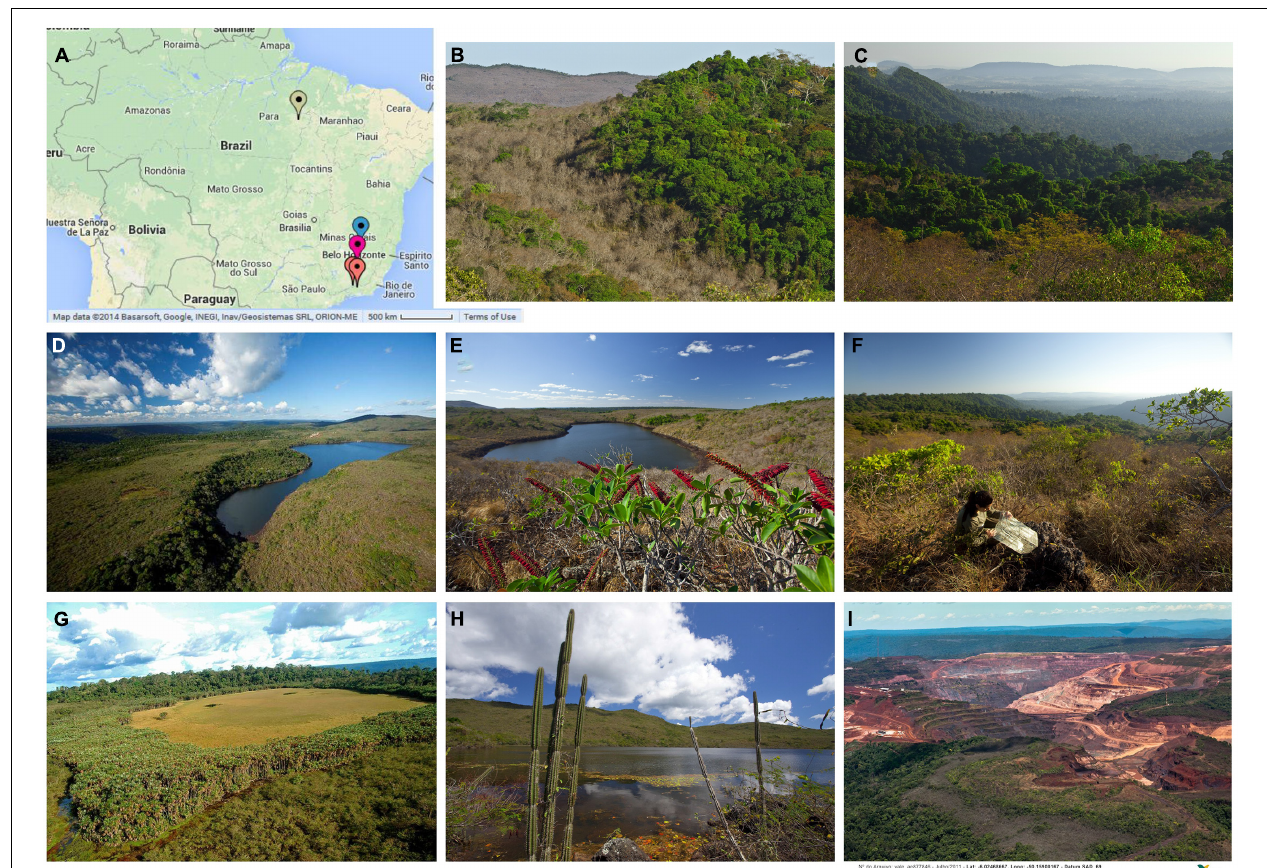
FIGURE 1 | Canga(A)LocationofcangainselbergsinvestigatedinCarajas andIQ. MapgeneratedandreproducedfromGoogleMaps.Greenindicator (Nunes,2009),redindicators(Jacobietal.,2007),violetindicator(Vianaand